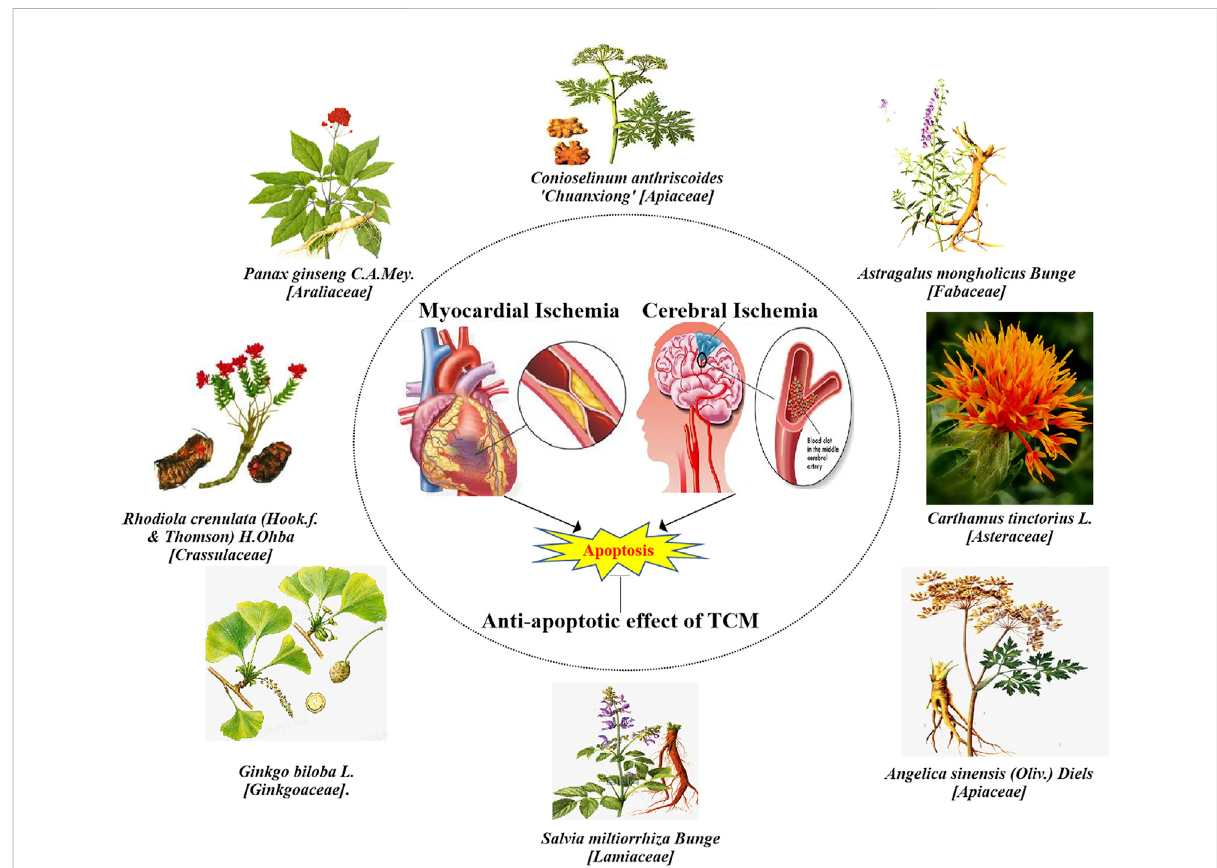
The representative Chinese herbs in treating myocardial ischemia and cerebral ischemia. Most herbs promote blood circulation and remove blood stasis, such as Panax ginseng C.A.Mey. [ Araliaceae ], Astragalus mongholicus Bunge [Fabaceae], Conioselinum anthriscoides [Apiaceae], Rhodiola crenulata (Hook.f. & Thomson) H. Ohba [ Crassulaceae ], Carthamus tinctorius L. [ Asteraceae ], Ginkgo biloba L. [ Ginkgoaceae ], Angelica sinensis ( Oliv. ) Diels [ Apiaceae ] and Salvia miltiorrhiza Bunge [ Lamiaceae ] can treat ischemic cardio-cerebrovascular injury and various complications through